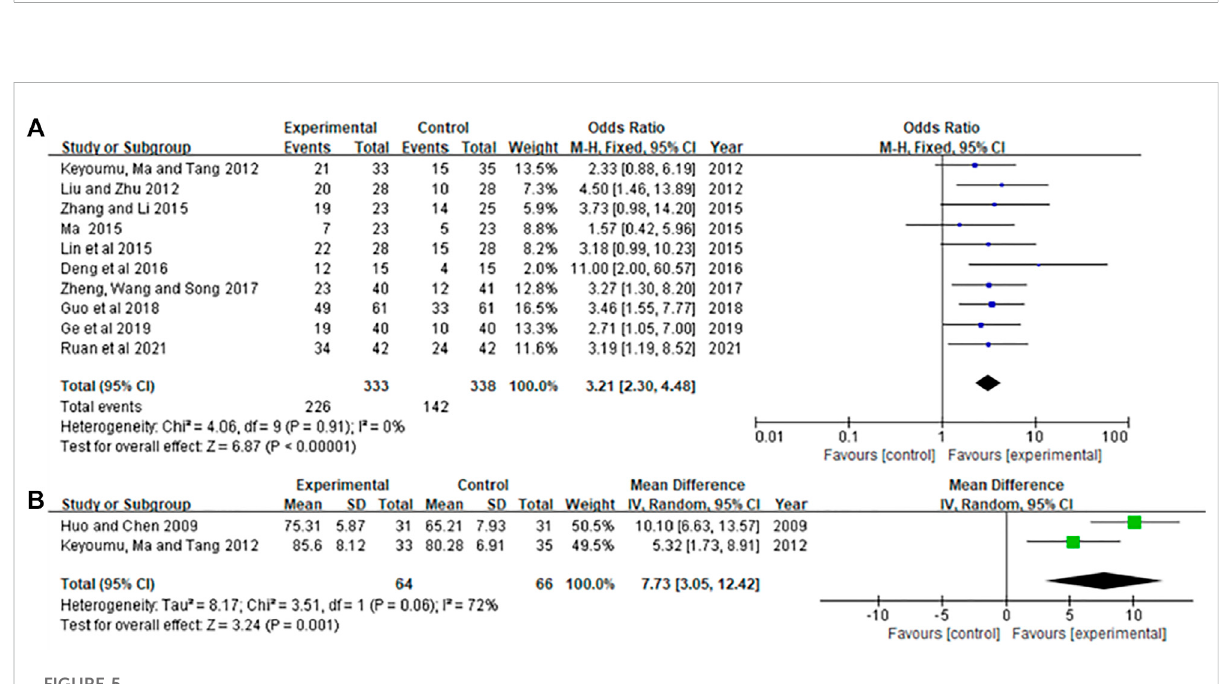
FIGURE 4 Meta-analysis of DCR.